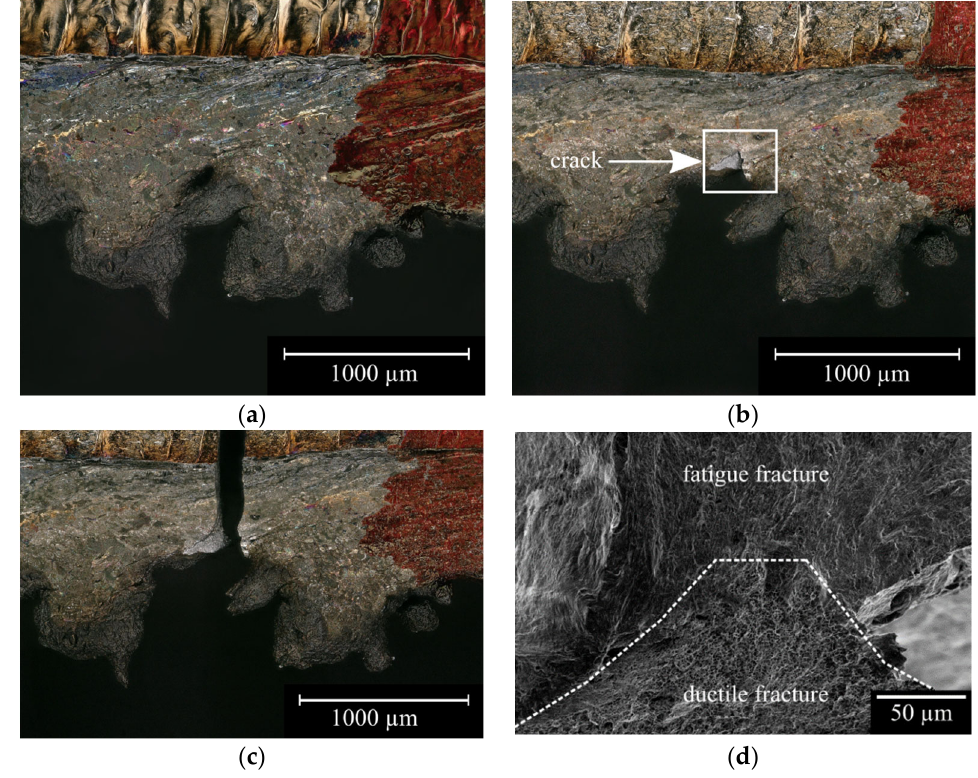
Figure 10. Crack initiation origin of a representative specimen with very coarse dross in the states ( a ) before pre-deformation and ( b ) after pre-deformation. ( c ) The fatigue crack origin starting from the dross. ( d ) SEM image of the crack initiation site with di ff erent fracture surface characteristics.